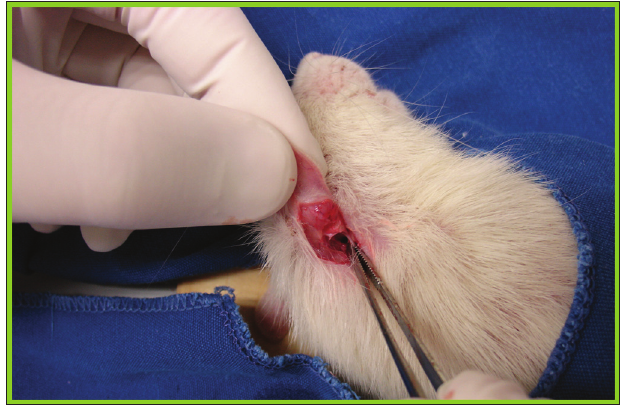
Figure 2. Exposure of the external ear canal and mastoid.